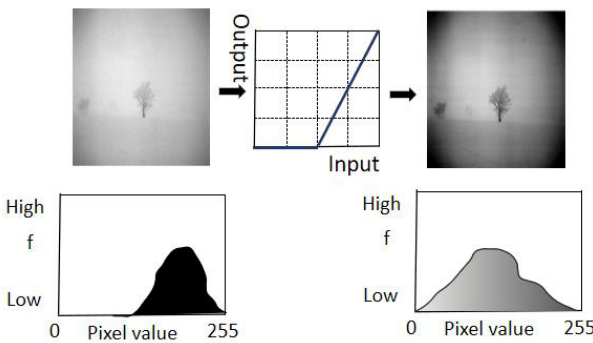
Figure 1. Image greyscale adjustment—fine tuning of greyscale values. Adjusts the pixel values of the image according to certain mapping relationships. Additionally, the image is grayscale transformed, i.e., the brightness of the grayscale image or the color matrix of the color image is adjusted, where [low_in; high_in] is the grayscale range to be transformed in the original image, and [low_out; high_out] is the grayscale range after the transformation. This mapping relationship allows us to intercept areas of the grey-scale image transformation by adjusting the values of low_in and high_in, and then intercept pixels by adjusting the values of low_out and high_out to obtain a new grey-scale